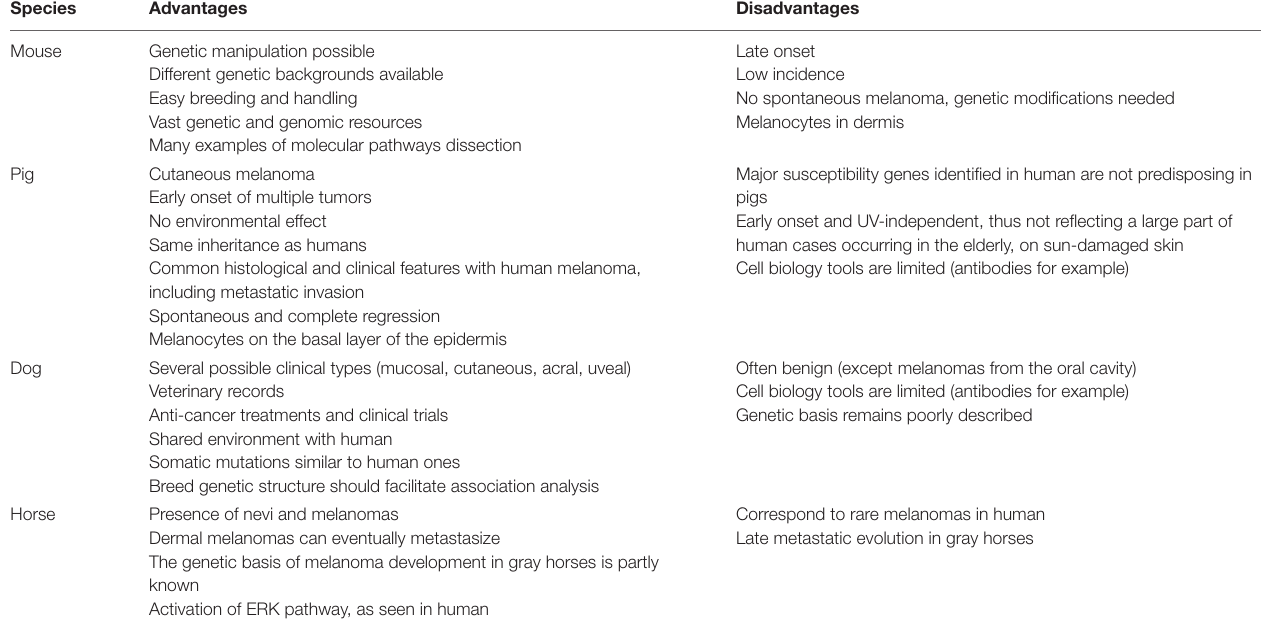
TABLE 1 | Examples of animal models of melanoma, and some of their advantages/disadvantages to explore melanomagenesis in human.